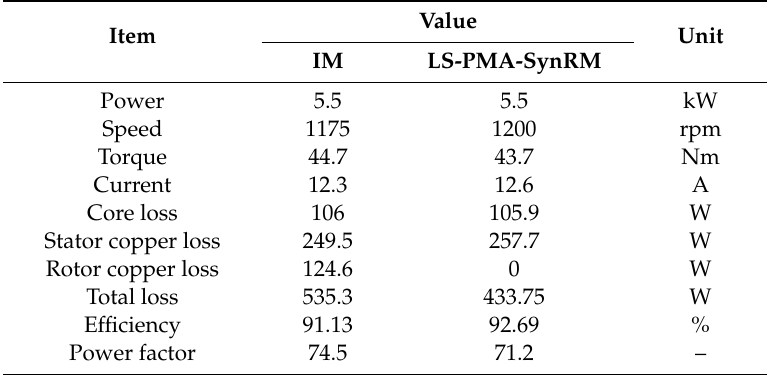
Figure 16. Experiment result of manufactured motors: ( a ) IM, ( b ) LS-PMA-SynRM. Table 6. Experiment result of IM and LS-PMA-SynRM using the power analyzer.